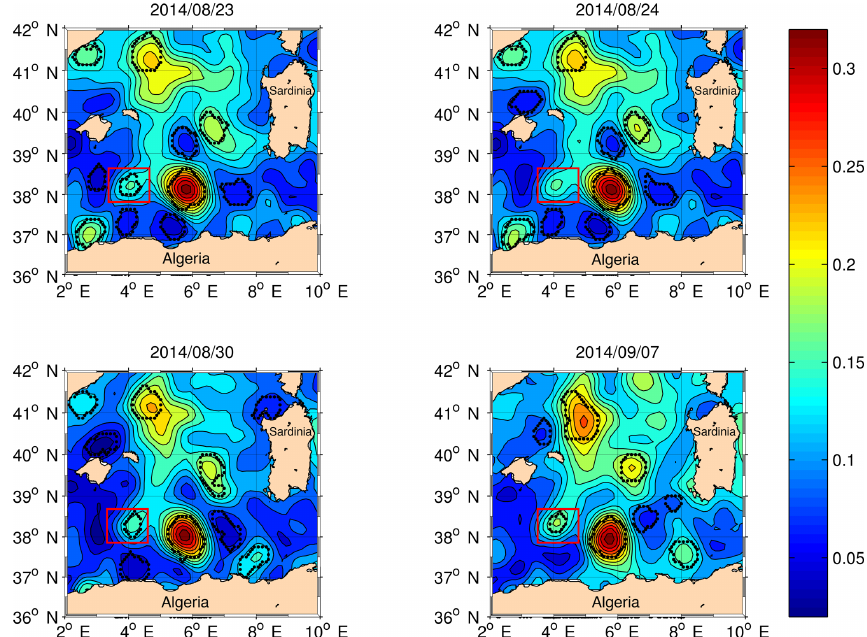
Figure 2. Maps of SLA (m) for four different days. The black dots indicate the Okubo–Weiss closed contour and thus the structures detected by the algorithm. The red square indicates the eddy not correctly identified by the detection algorithm alone. In fact, on 24 August 2014, the structure probably became weaker and undetectable with this method. By running the continuity routine we join the tracks and obtain a single eddy track 203 days long. This structure has been described and tracked by Cotroneo et al. (2016), who computed the same